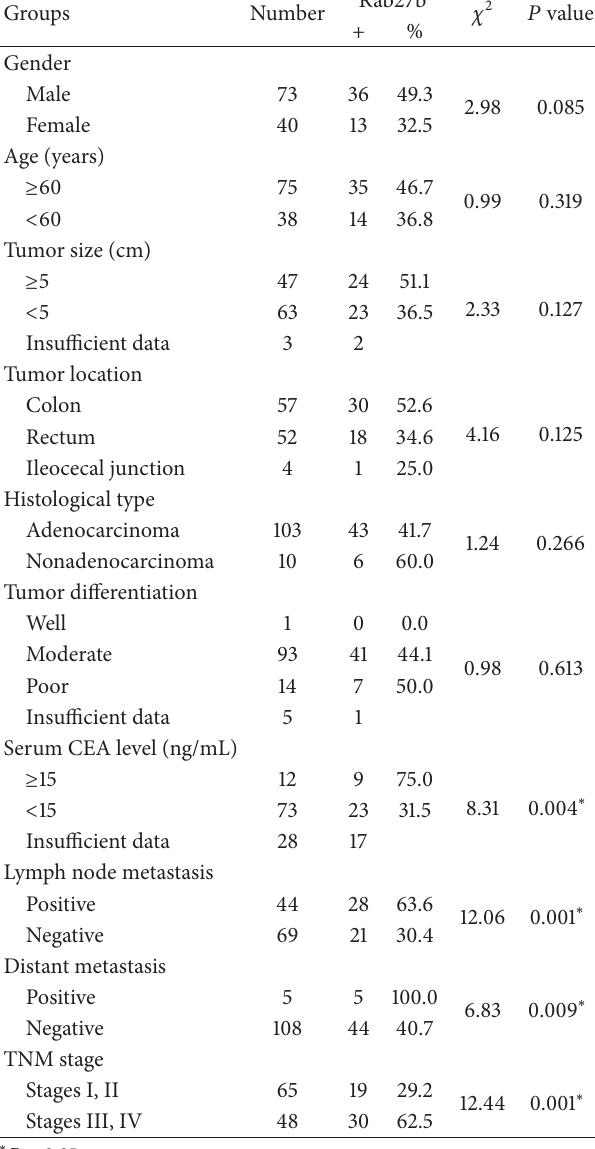
Table 1: Correlation of Rab27b expression with clinicopathological characteristics of 113 CRC